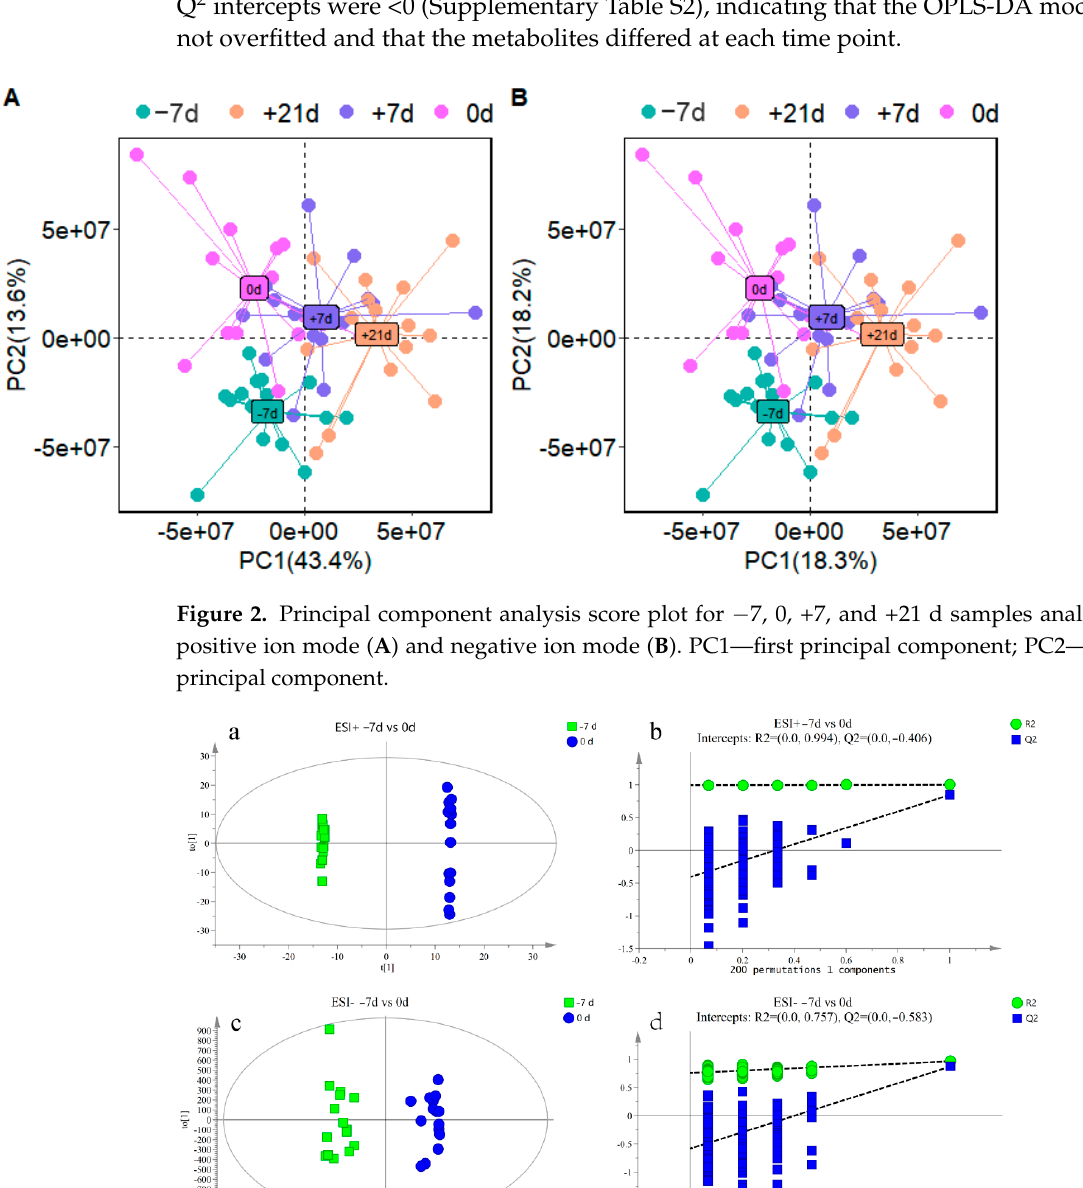
Figure 4. ( a , b ) Orthogonal partial least squares discriminant analysis (OPLS-DA) of scores and per- mutation test plots for the +7 d and 0 d group samples analyzed in the positive ion mode, respec- tively. ( c , d ) Orthogonal partial least squares discriminant analysis of scores and permutation test plots for the +7 d and 0 d group samples analyzed in the negative ion mode, respectively. t[1]—first principal component; to [1]—second orthogonal component. The intercept limit of Q 2 , calculated by regression line, is the plot of Q 2 from permutation test in the OPLS-DA model.